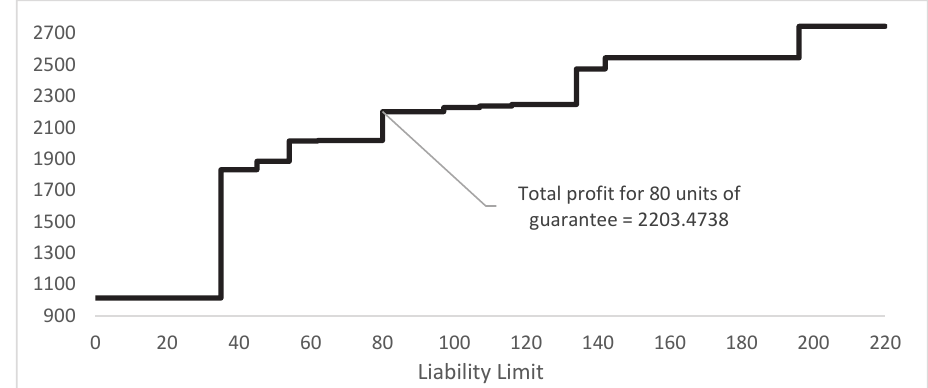
Fig. 4 . Profit on different liability limit